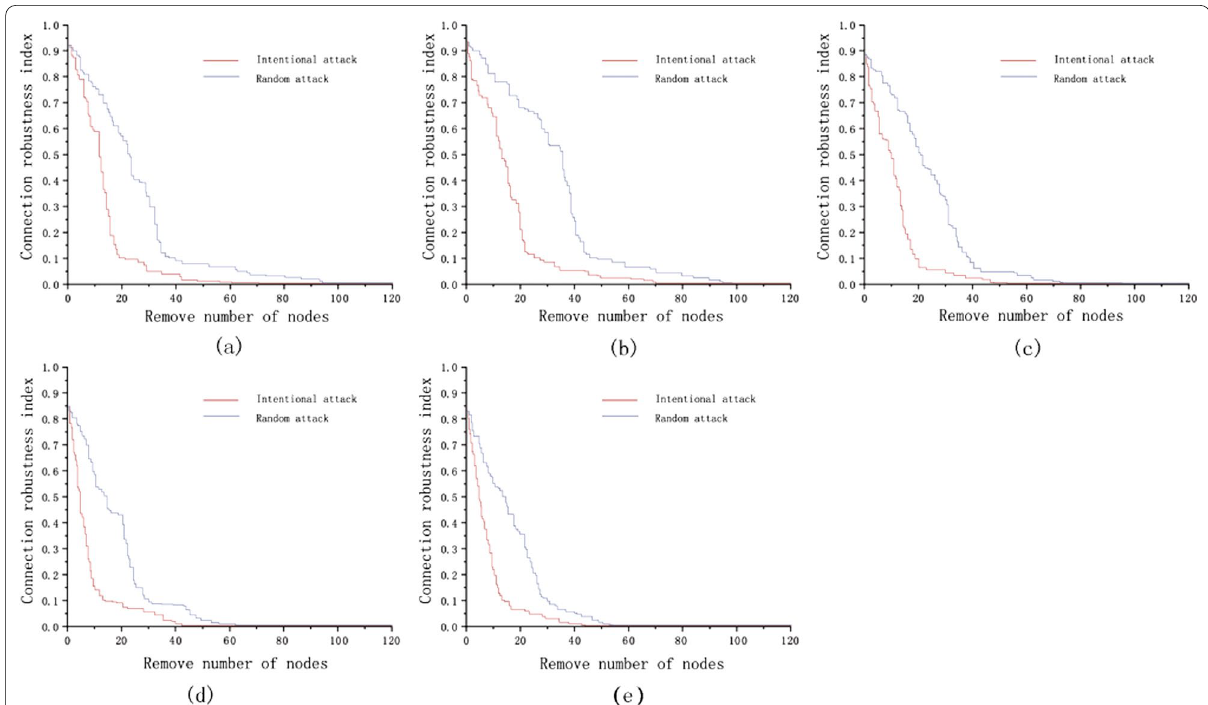
Fig. 9 Connection robustness analysis of the GI network in multiple scenarios after optimization. a Current scenario, b 5% economic growth scenario, c 10% economic growth scenario, d 15% economic growth scenario, e 20% economic growth scenario